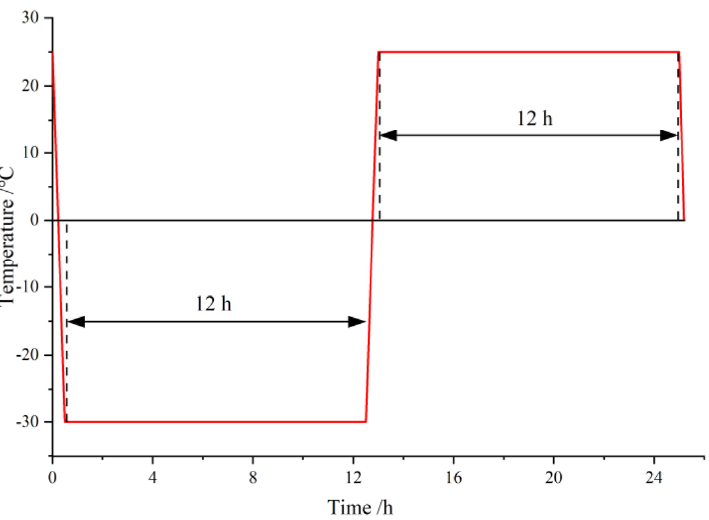
Figure 3. Schematic diagram of temperature variation in the freeze-thaw cycle test.